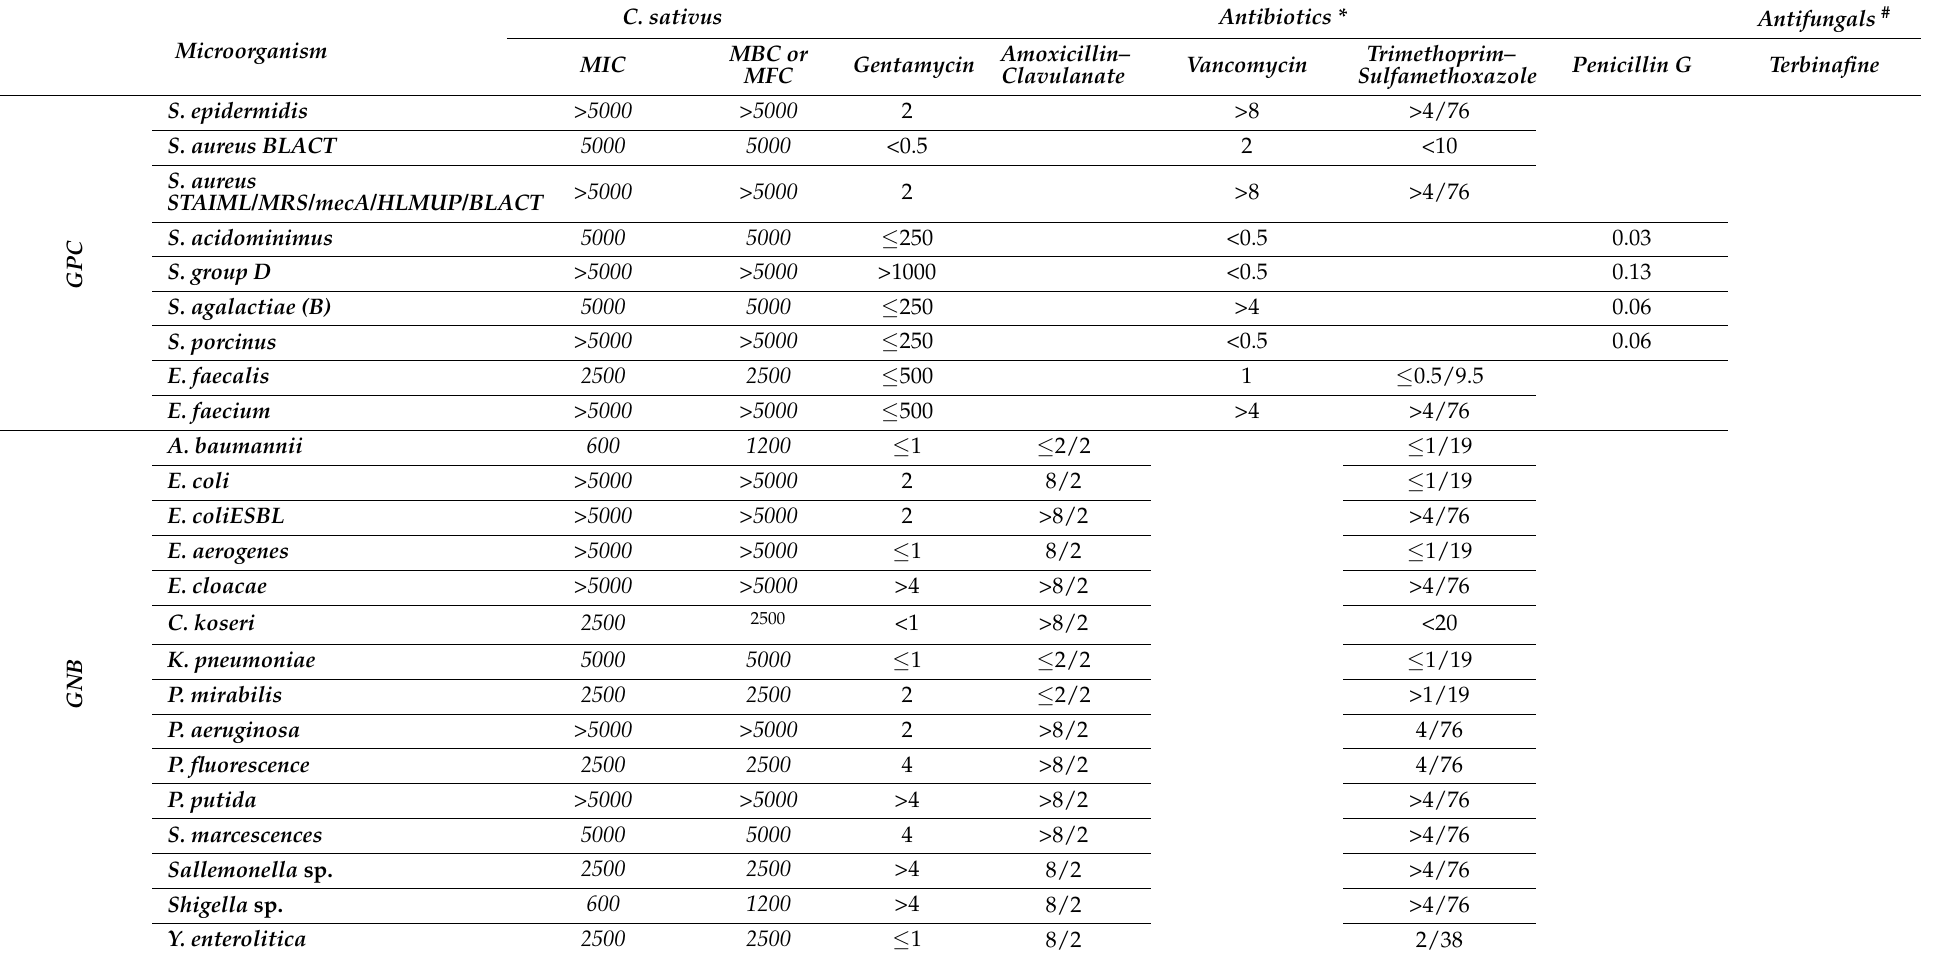
Table 6. The MIC, MBC, and MFC ( µ g/mL) of C. sativus decocted extract, and the MIC of antibiotics and antifungal